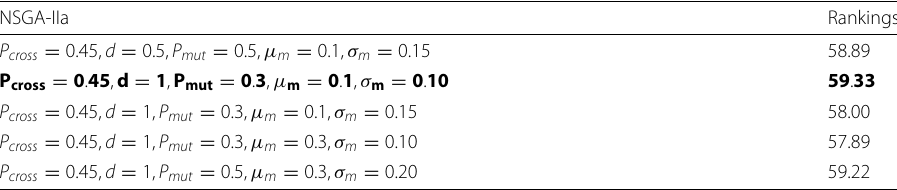
Table 4 Average rankings achieved by the Friedman test for the NSGA-IIa algorithm with different parameter